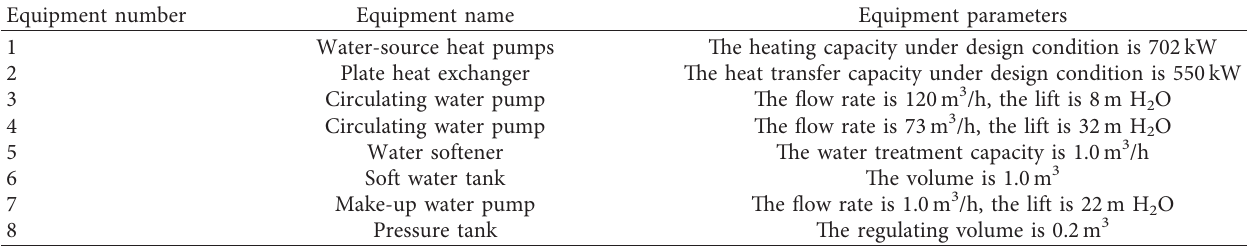
Table 5: Parameters of main